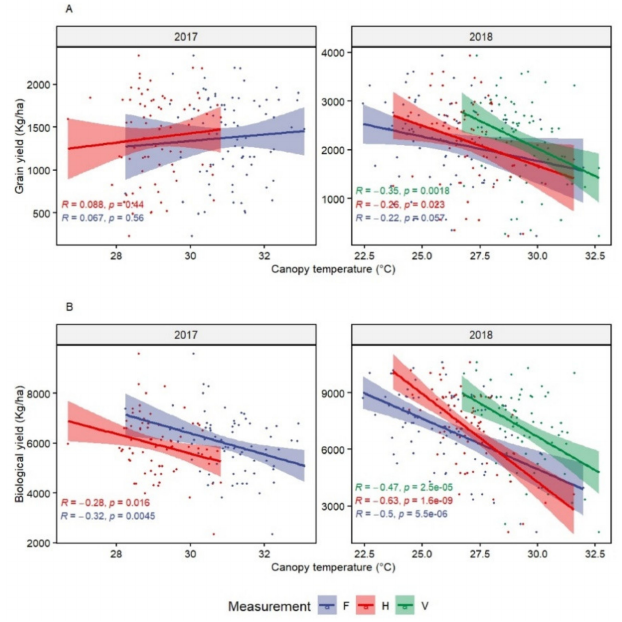
Figure 5. Linear regression and the Pearson correlation coefficient of canopy temperature measured at vegetative stage (V), heading (H), and grain filling (F) versus grain yield ( A ) and biological yield ( B ) under continuous heat stress at wad Medani for two seasons (2016–2017 and 2017–2018). Chlorophyll content did not correlate significantly with GY and BY. Despite the higher correlation value between CHL and BY in comparison to GY, it was not significant (Figure 7). No difference was observed with regard to the time of measurement under continuous heat stress for CHL. The highest association with grain yield was obtained with GFR in 2018 (R = 0.93) and this correlation decreased to 0.56 in 2017. Fv/Fm collected at heading showed a significant correlation with GY (R = 0.4) in 2018 (Figure 8).